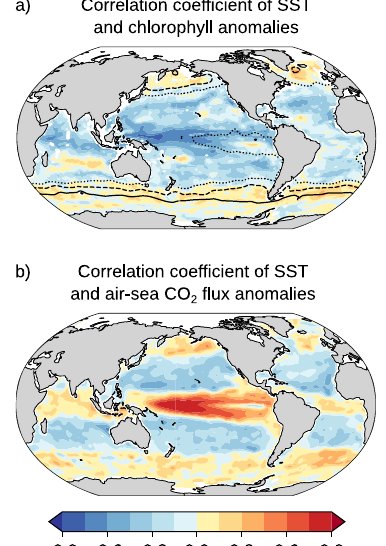
Fig. 3 | Correlationofsea-surfacetemperatureanomalieswith chlorophyll and air-sea CO 2 fl ux anomalies. The observation-based correlation coef fi cient of monthly sea surface temperature anomalies and monthly ( a ) chlorophyll con- centration anomalies over 1998 – 2018 and b air – sea CO 2 fl ux anomalies over 1982 – 2019 (see “ Methods ” ).The datawerelinearly detrendedprior to the analysis. A negative correlation between SST and chlorophyll anomalies indicates that chlorophyll, and possibly net primary production, is reduced and hence C T enhanced during MHWs. A negative correlation between SST and air – sea CO 2 fl ux anomaliesindicatesthatC T isreducedduringMHWs.Thecontourlinesin a display meannitrateconcentrationsfromtheWorldOceanAtlas2018(dotted:3 μ molkg − 1 , dashed: 10 μ mol kg − 1 , solid: 20 μ mol kg − 1 ). Net primary production is here approximated by observation-based chlorophyll concentration 48 , although chlor- ophyll is not always correlated with net primary production, particularly in sub- tropical regions 49